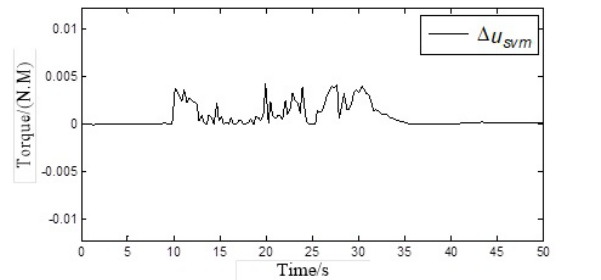
Fig. 7 Error of learning-based